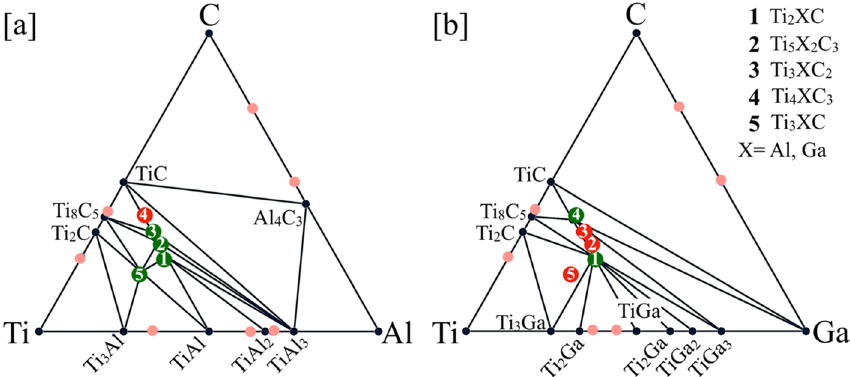
Figure 1. Ternary ( a ) Ti–Al–C, and ( b ) Ti–Ga–C convex hull based on experimentally known structures. The compositions marked as stable (green) and unstable (red) for given MAX phases 58 . The black and red (light) circles are stable and unstable binary/unary phases, respectively.